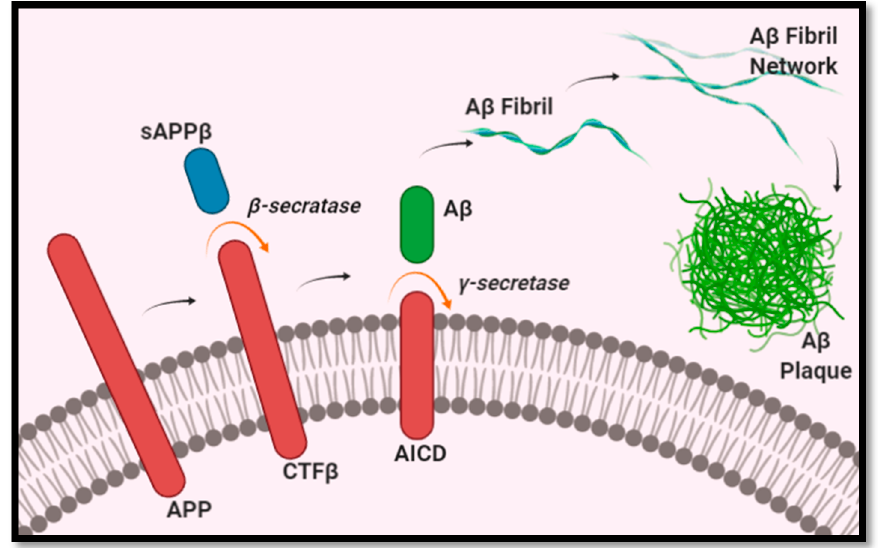
Figure 1. Generation of A β plaques.